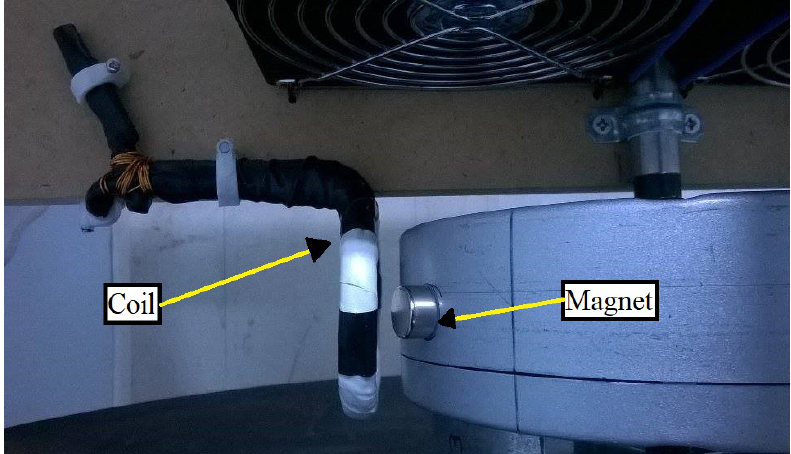
Figure 6. The second set of neodymium magnet and coil. The magnet is fixed to the motor and rotates along with it, passing next to the coil and inducing a voltage on